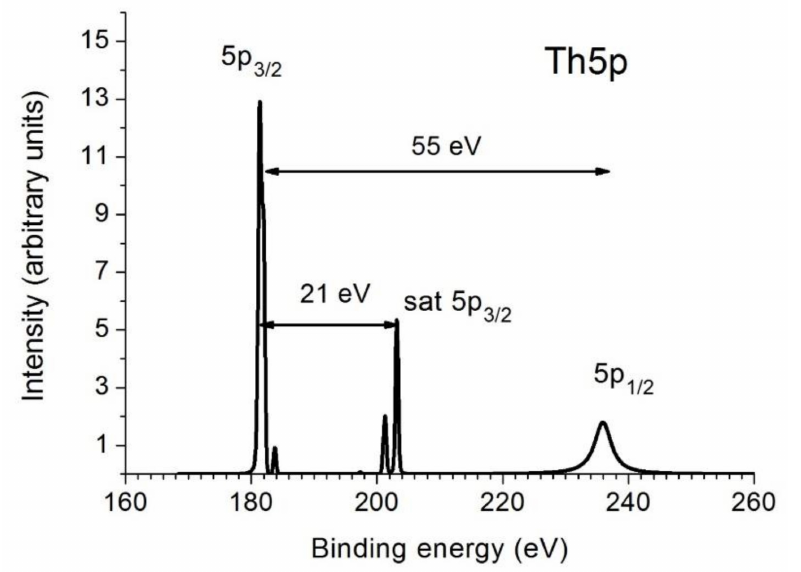
Figure 10. Theoretical Th 5p photoelectron spectrum. The satellite structures of the 5p 3/2 line were calculated by the CI method. The spectral function of 5p 1/2 line was calculated in the second order of perturbation theory. The lineshape 5p 1/2 is slightly asymmetrical, with a raised low-binding energy